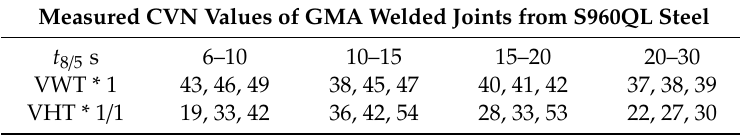
Table 4. Measured CVN values of GMA welded joints from S960QL